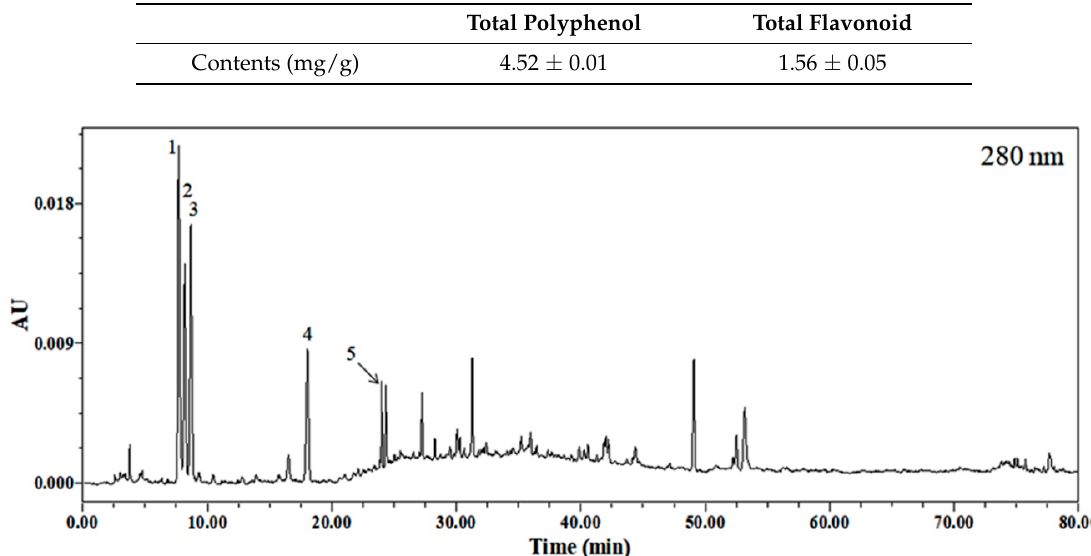
Figure 1. HPLC chromatogram of Persea americana Mill. (avocado) extract detected at 280 nm. Table 1. Retention time (Rt), precursor ion, molecule formula, and ultraviolet maxima ( λ max) of peaks identified in ethanol extract of P. americana Mill. (EEP).